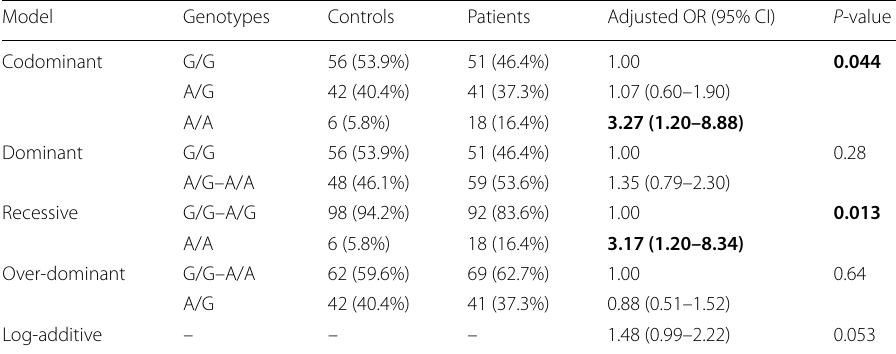
Data are presented as number (percentage). Adjusted odds ratio (OR) by age. Bold values indicate statistical significance at P ‑value < 0.05 CI confidence